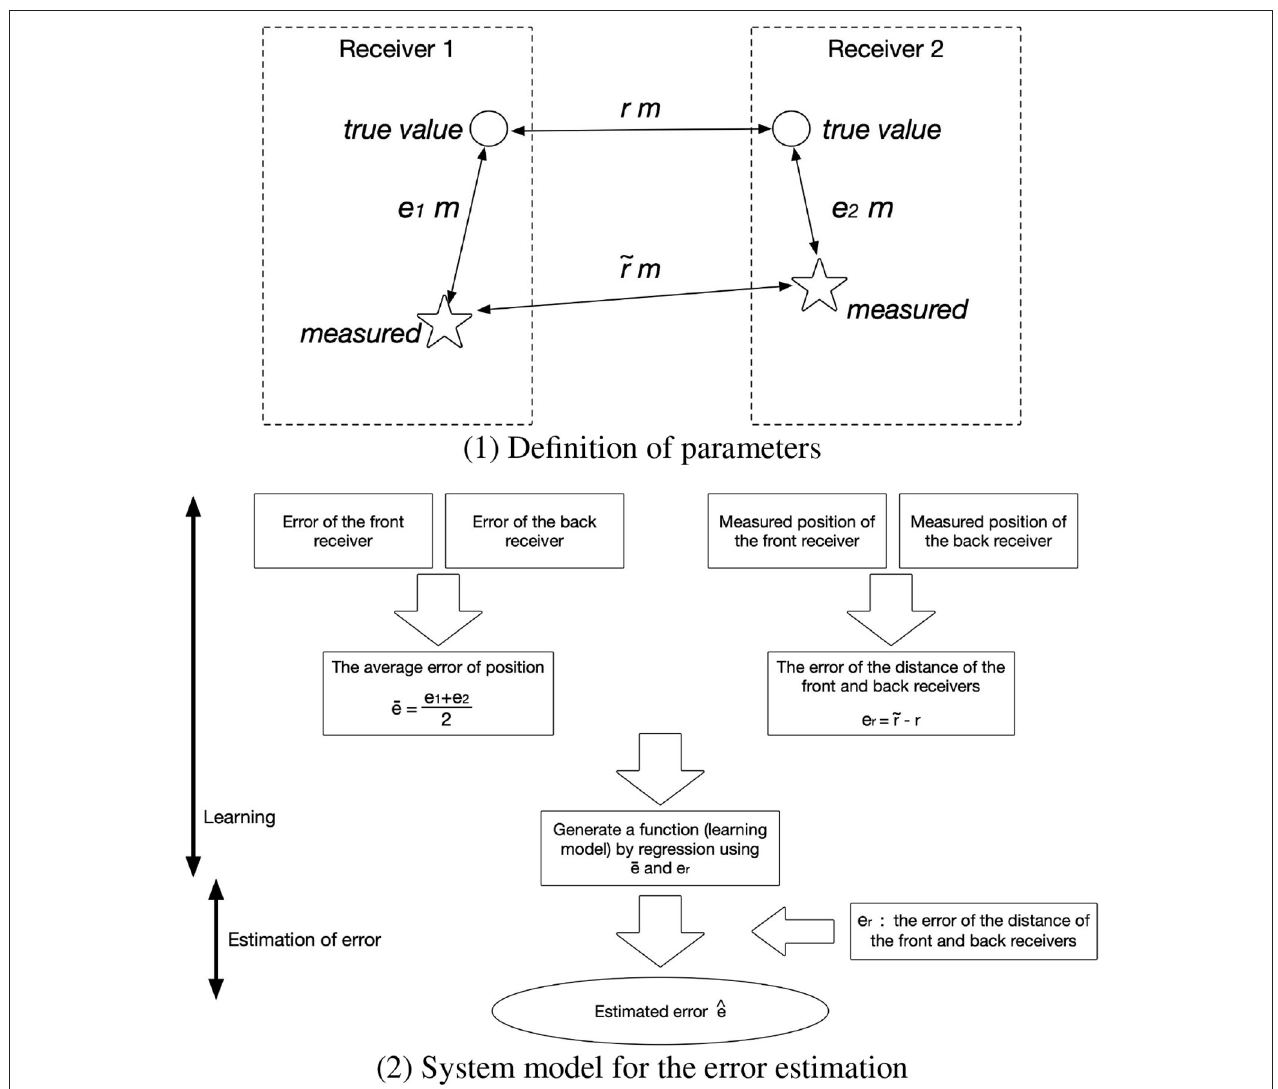
FIGURE 6 | Definition of parameters and System model for the error